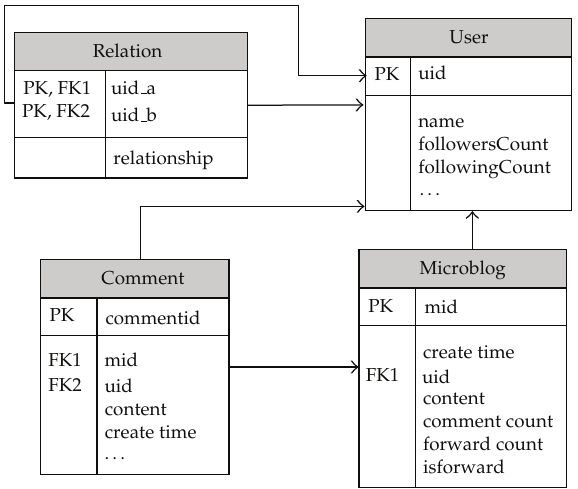
Figure 1: The logical view of the